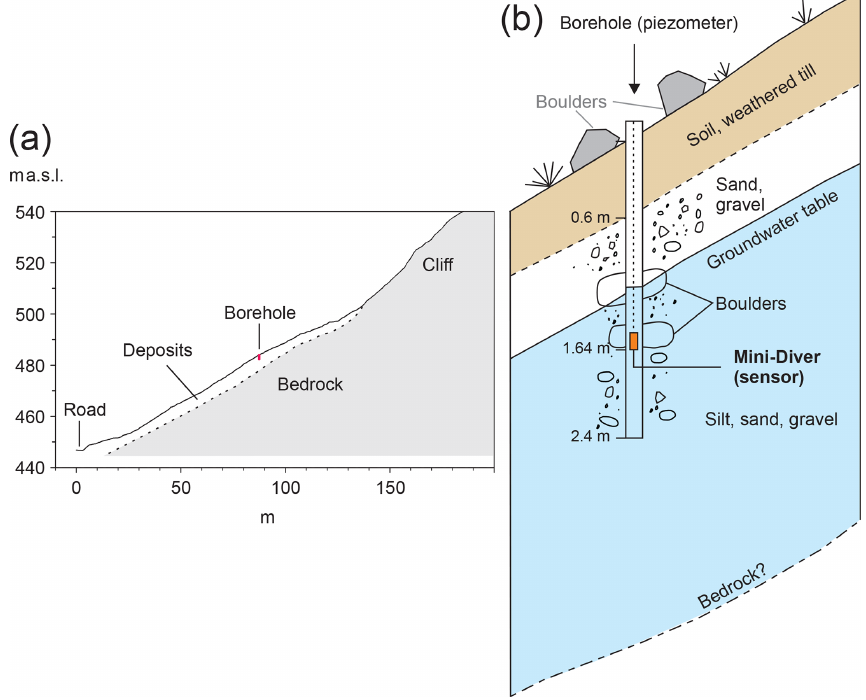
Figure 5. Profile of the hillside just south of the southern slide scar of the 2007 landslide (Fig. 4b), showing the borehole with the instrumented piezometer. (a) Average steepness of the sediment-covered slope is 25–26 ◦ . The dashed line indicates where we believe the boundary between till and bedrock is located, based on observations from the 2007 slide scar (Fig. 4b). (b) The Mini-Diver (sensor) is suspended from a wire in the piezometer and anchored 1.64m below the surface. The top 60cm of deposits consists of organic soil and weathered till, with firm till below that. We drilled through boulders at depths of ca. 1 and